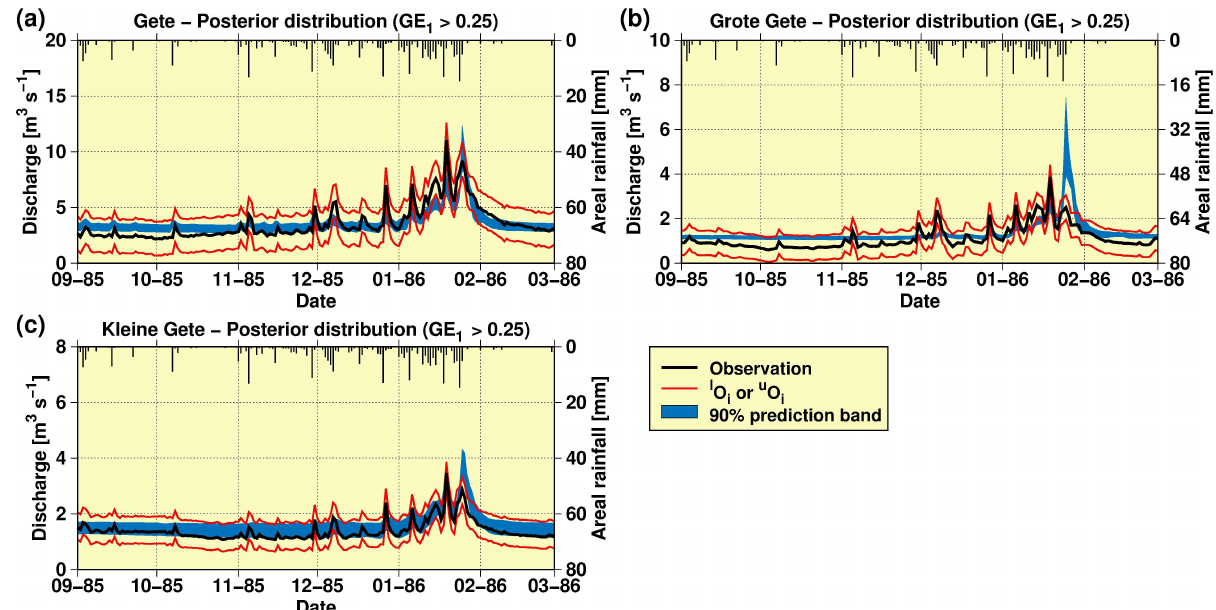
Figure 9. Ninety percent streamflow prediction limits in the validation period [1 September 1985– 1 March 1986] using the E 1 likelihood measure and the posterior likelihood distribution, after conditioning based on observed streamflow at the three study gauging stations (i.e., the multi- site test) and the H-Q data uncertainty for: ( a ) the Gete station; ( b ) G the rote Gete station; and ( c ) the Kleine Gete